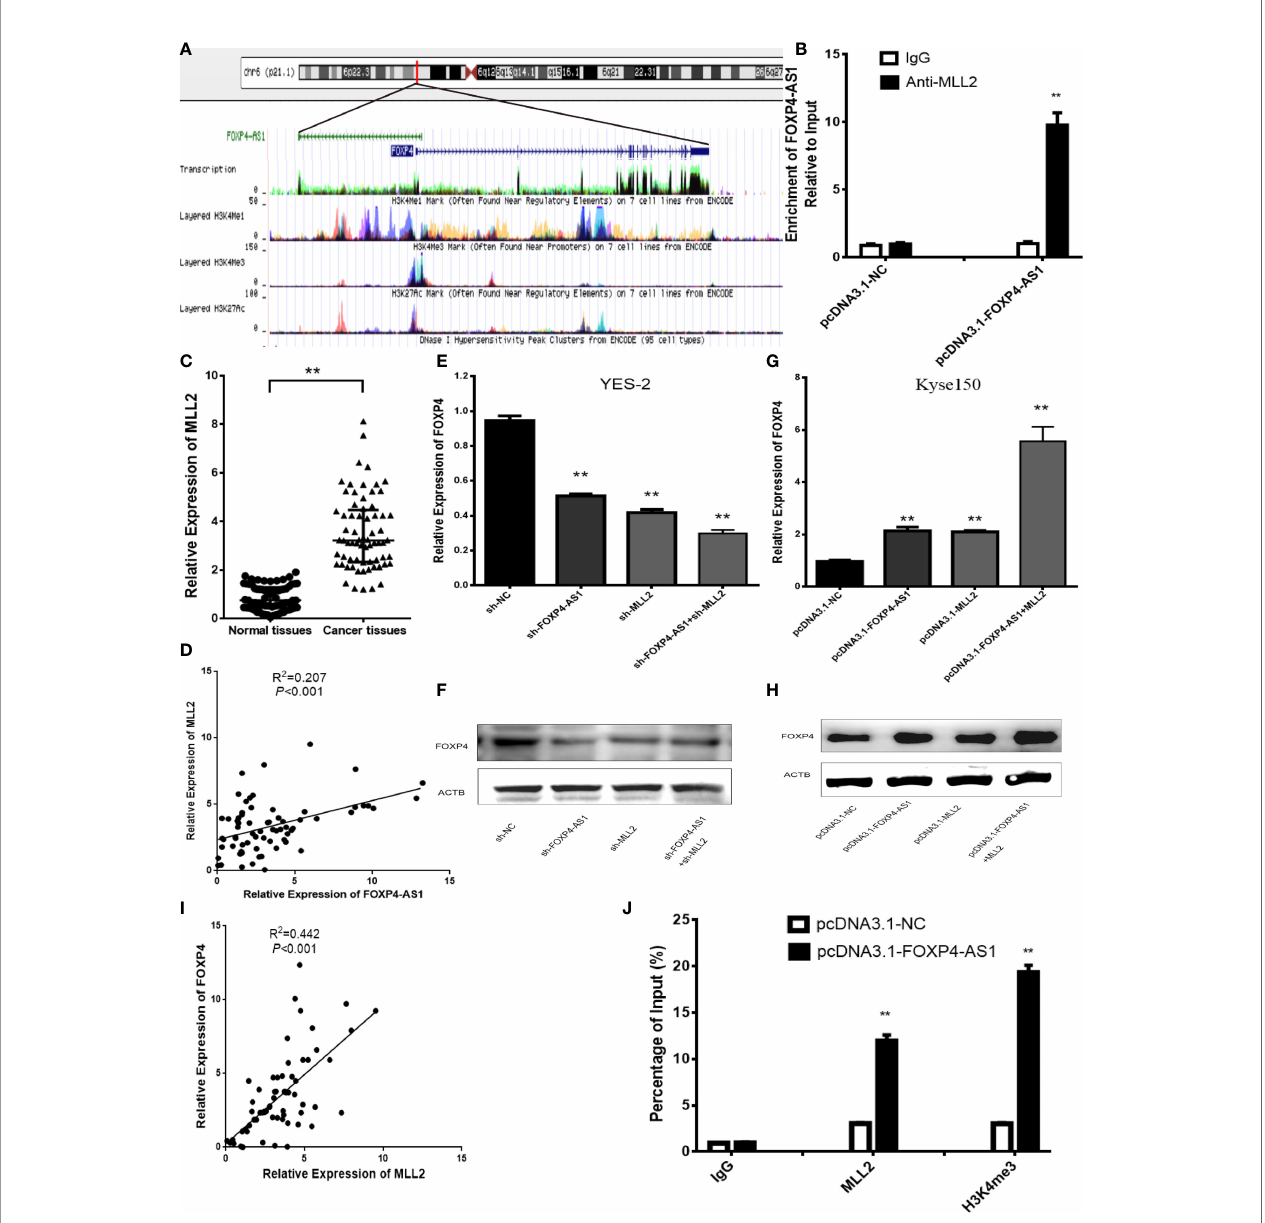
FIGURE 4 | FOXP4-AS1 upregulates FOXP4 expression through interacting with MLL2. (A) Epistatic regulatory maps of FOXP4 and FOXP4-AS1 by UCSC. (B) The binding of FOXP4-AS1 to MLL2 in Kyse150 by RIP. (C) The expression of MLL2 in ESCC by qRT – PCR. (D) The association between FOXP4-AS1 and MLL2 by qRT – PCR. FOXP4 mRNA (E, G) and protein (F, H) by coexpressing FOXP4-AS1 and MLL2. (I) The correlation between FOXP4-AS1 and MLL2 by the qRT – PCR. (J) FOXP4-AS1 increased MLL2 and H3K4me3 enrichment in the FOXP4 promoter as determined by ChIP assay. ** p <